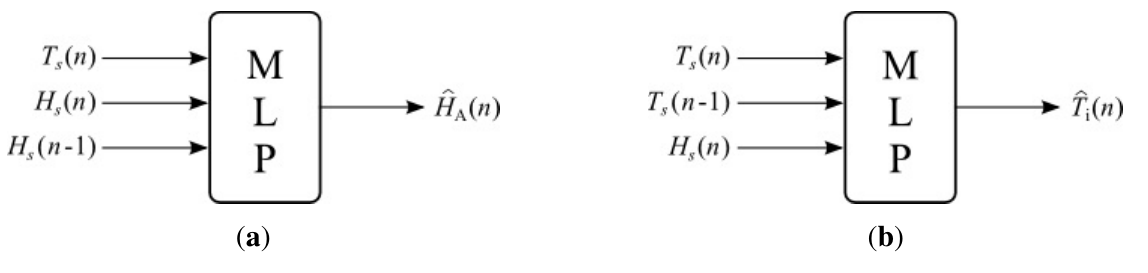
Figure 9. Training structure of networks: ( a ) humidity and ( b )